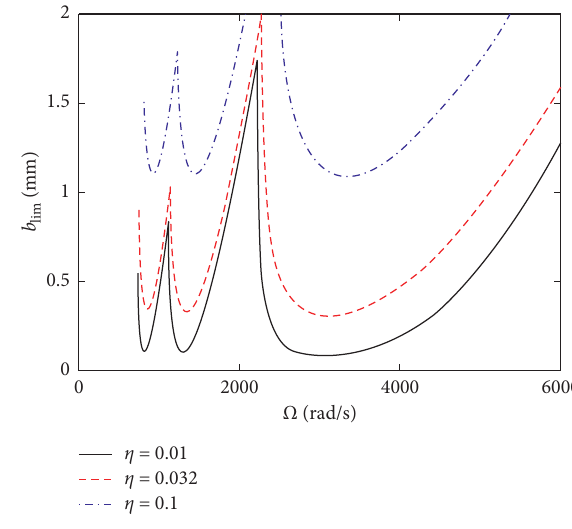
Figure 5: Effect of the length of the cutting bar.